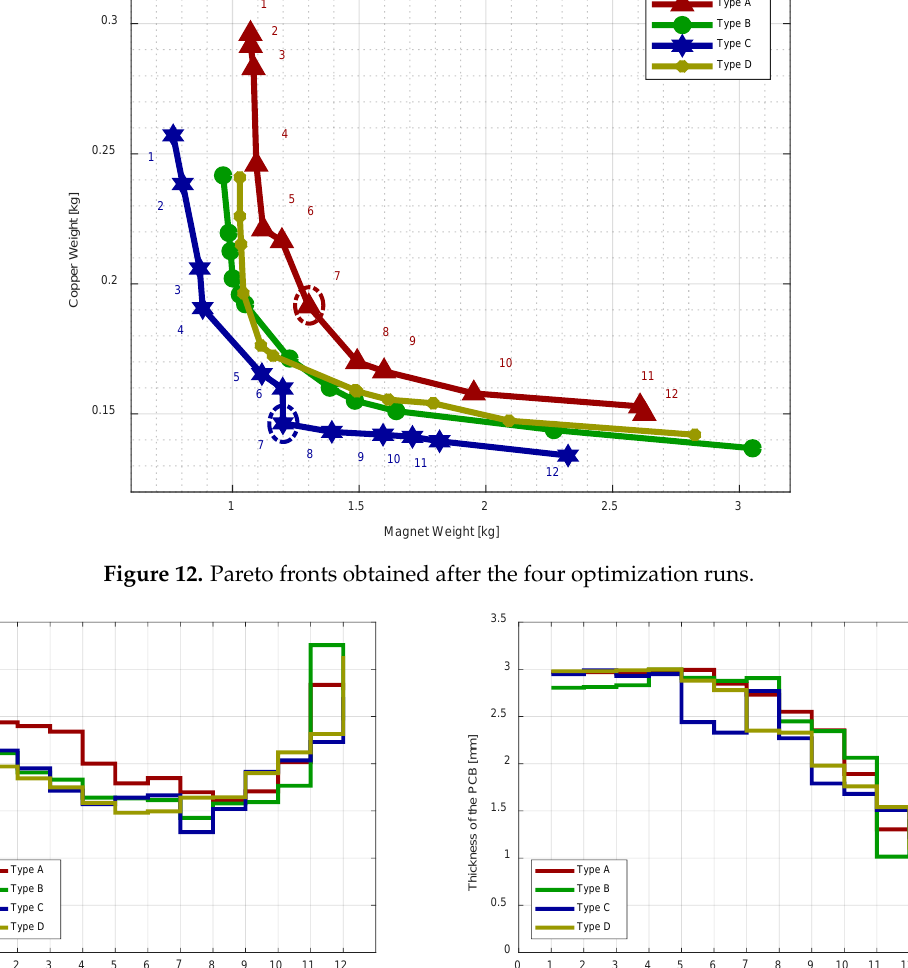
( a ) ( b ) Figure 14. Permanent magnet arc ( a ) and thicknesses ( b ) of the machines belonging to the four Pareto fronts. ( a ) ( b ) Figure 15. Stator ( a ) and rotor ( b ) magnetic yokes weights of the machines belonging to the Pareto fronts. 5.1. Comparison Starting from the results shown in the previous paragraph, the two outermost Pareto fronts, corresponding to Type A (both stator and rotor ironless) and Type C (both stator and rotor with iron lamination) machines, are considered.